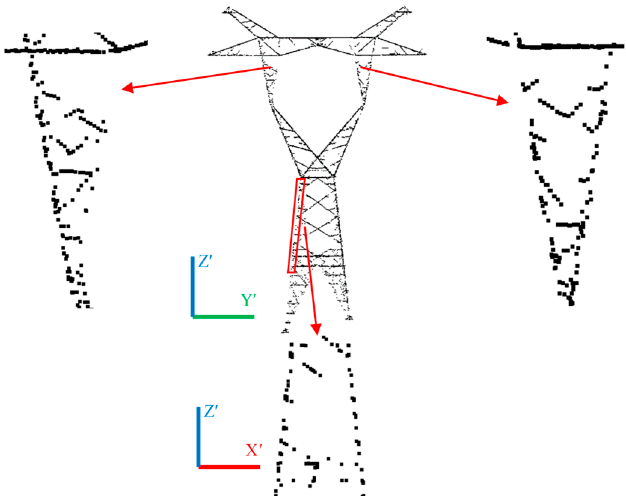
Figure 28. Pylon points with data loss.